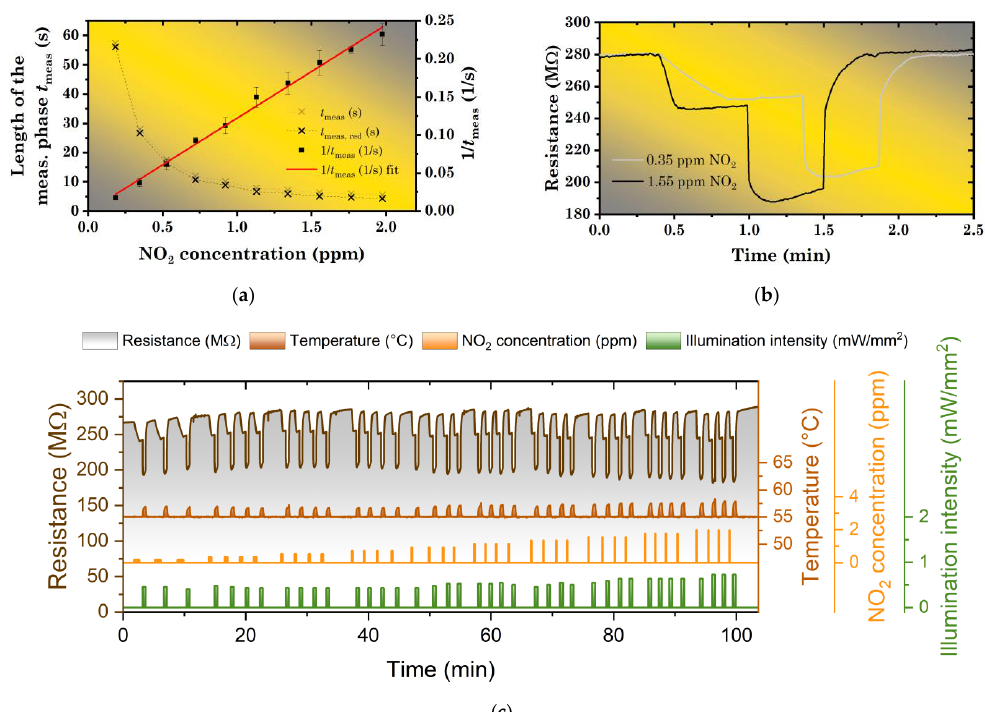
Figure 5. ( a ) Length of the measurement period t meas as a function of NO 2 concentration (0.2–2 ppm); ( b ) Illustration of the measurement for two different NO 2 concentrations (0.35 and 1.55 ppm). ( c ) Photoregeneration of ZnPc sensor by LED illumination (λ = 441 nm) at the operating temperature of 55 °C using single photoregeneration pulses (“constant exposure dose” regime).